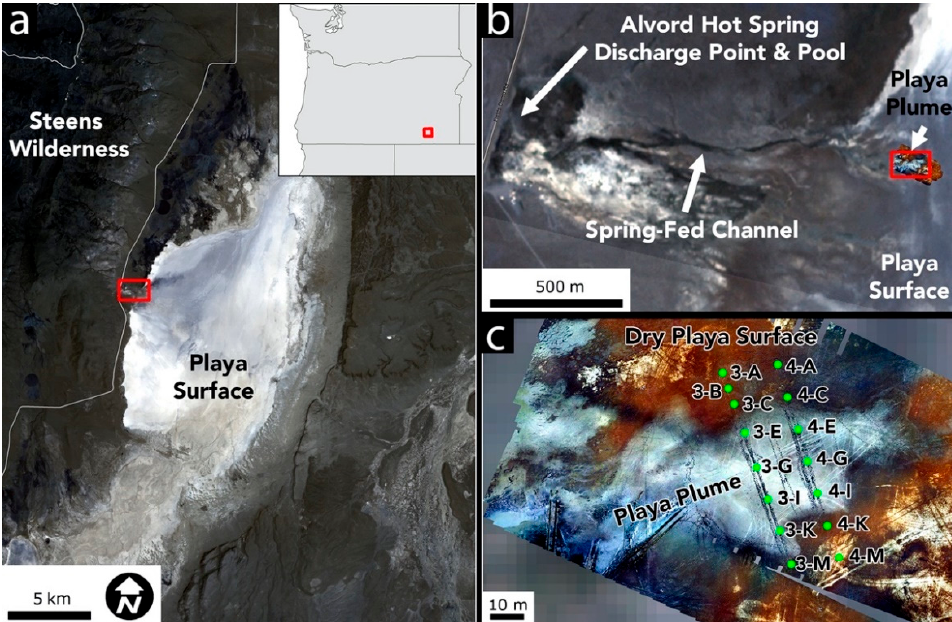
Figure 1. Context map of the Alvord Desert and Alvord Hot Springs (AHS). ( a ) Regional setting showing the full Alvord Desert playa and context location map in Oregon, USA. Portion of Landsat 8 image LC08_L1TP_043030_20190816_20190902. ( b ) Overview of the AHS discharge plume. Planet image 20190814_182056. ( c ) Overview of the AHS plume sampling site. Green points denote ground sampling transect points. Orthoimage produced from drone-derived color imagery.